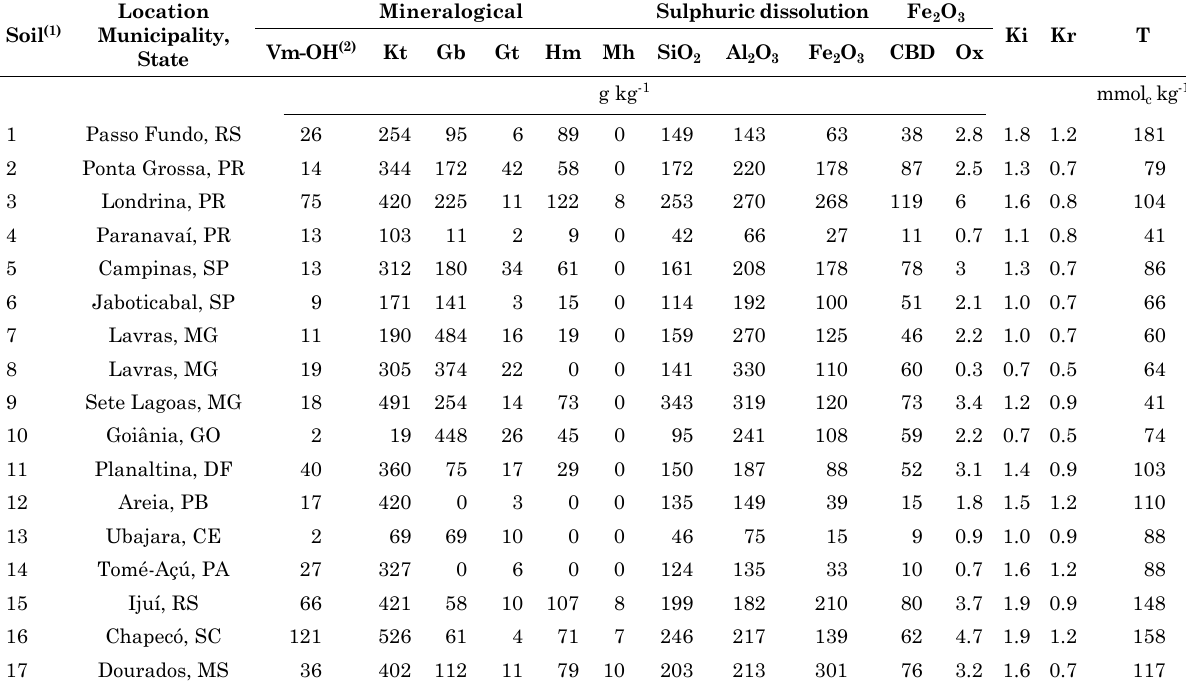
Table 1. Soil characterization (chemical and mineralogical properties) from the 0.00-0.20 m layer of 17 brazilian oxisols Soil